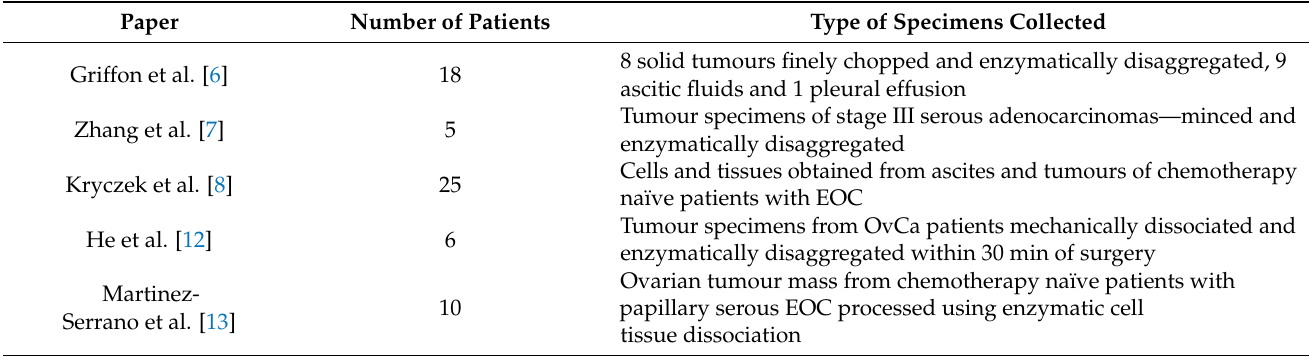
Table 2. Summary of papers, which used primary patient specimens to develop spheroid